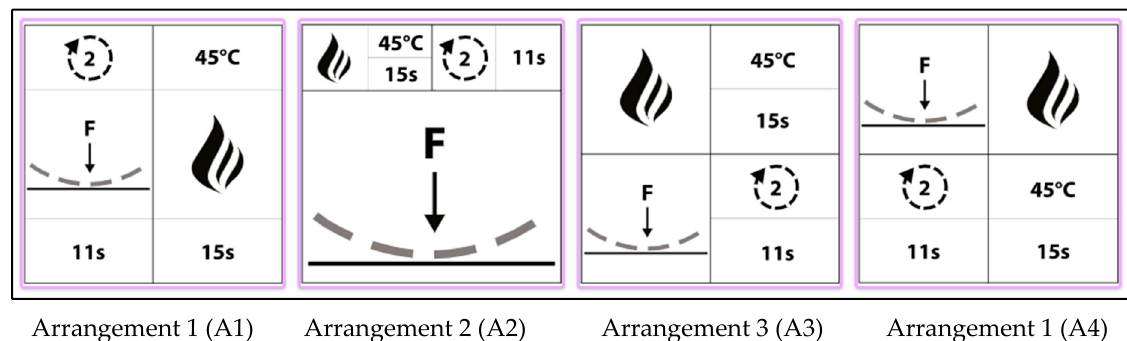
Figure 4. The four alternative arrangements of 4D Printing symbols.